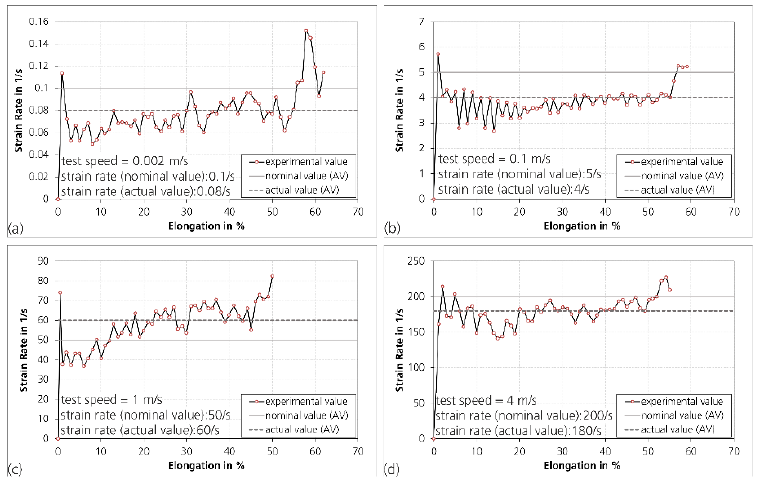
Figure 7. Nominal and actual values of the strain rate obtained during the tests for nominal strain rate 0.1/s ( a ), 5/s ( b ), 50/s ( c ), and 200/s ( d ).